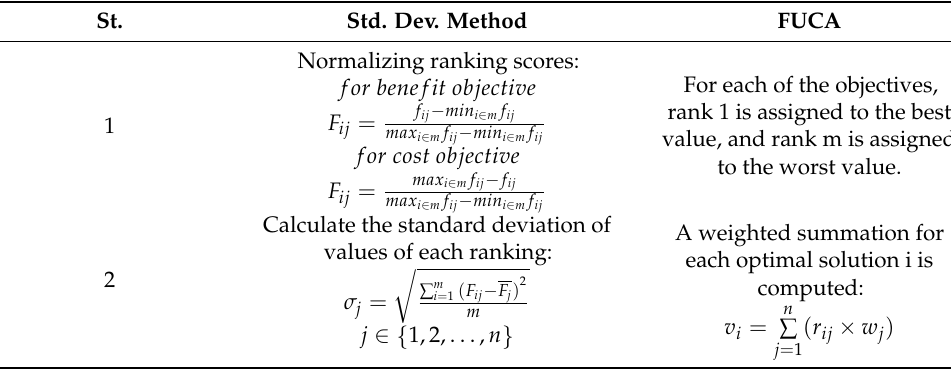
Table A3. Methodological Stages of Std. Dev. Method and FUCA. St. Std. Dev. Method FUCA Normalizing ranking 1